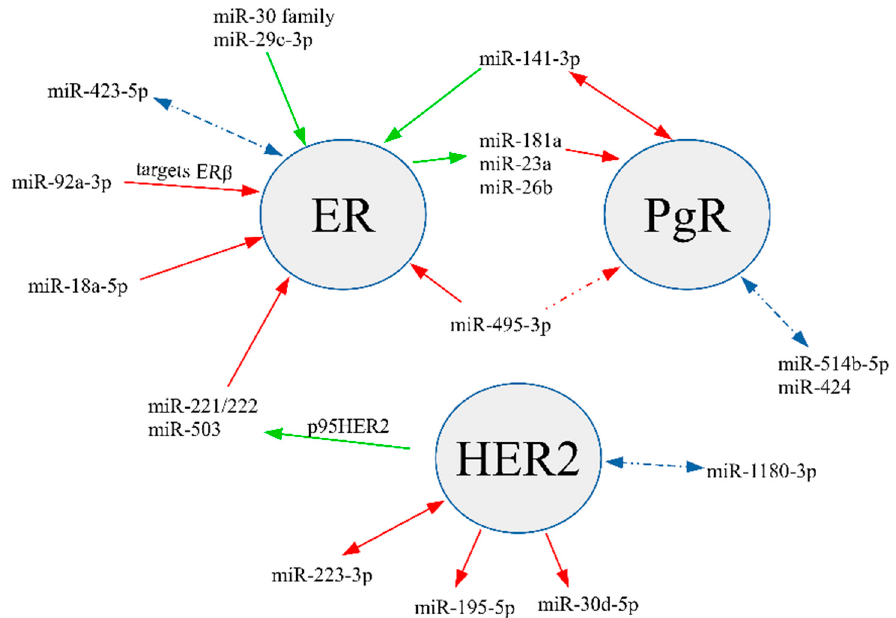
Figure 4. Key interactions between selected miRNAs, ER, PgR, and HER2. Red lines illustrate a known downregulating effect or an inverse association between miRNA and receptor; green lines depict an upregulating effect or a positive association between miRNA and receptor; blue lines show a potential relationship.